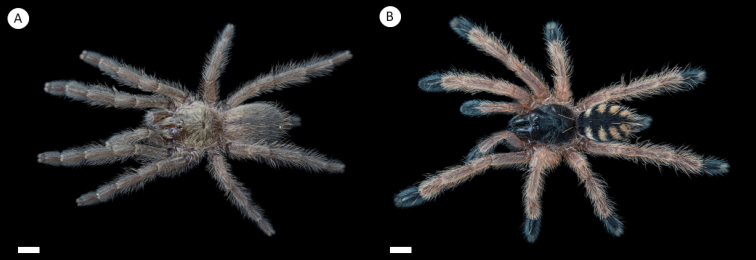
Ontogenetic pattern change A juvenile of TapinaucheniusB juvenile of Pseudoclamoris. Scale bar: 5mm.